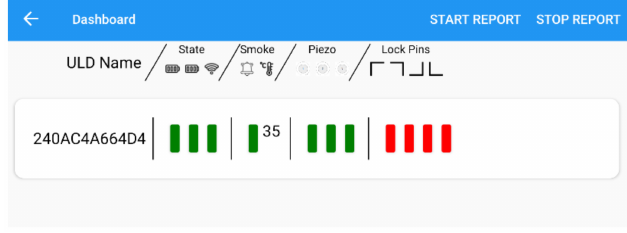
Figure 5. ULD overview in the HMI application’s dashboard.